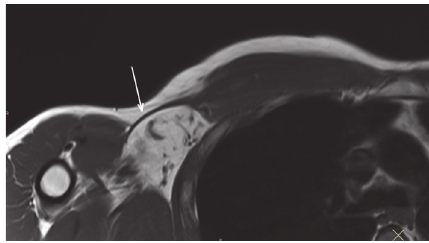
Figure 2: MRI axial T1 showing tendon retracted medial to the anterior chest wall and absence of any muscle fatty infiltration.